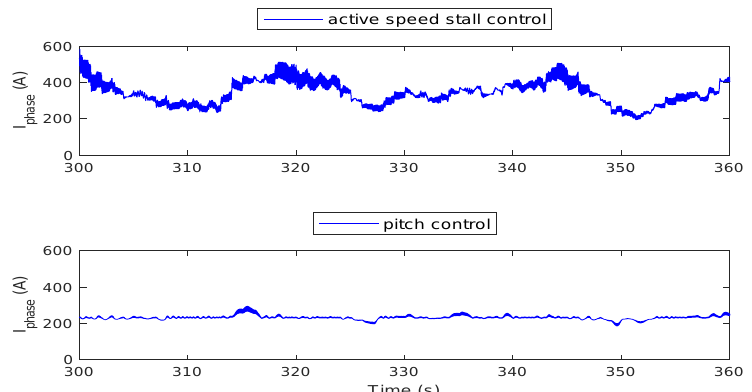
Figure 26. Generator phase currents (rms values) in the active speed stall- and the pitch-controlled turbine, under the influence of turbulence and wave-induced tidal stream velocity oscillation (as shown in Figure 4).